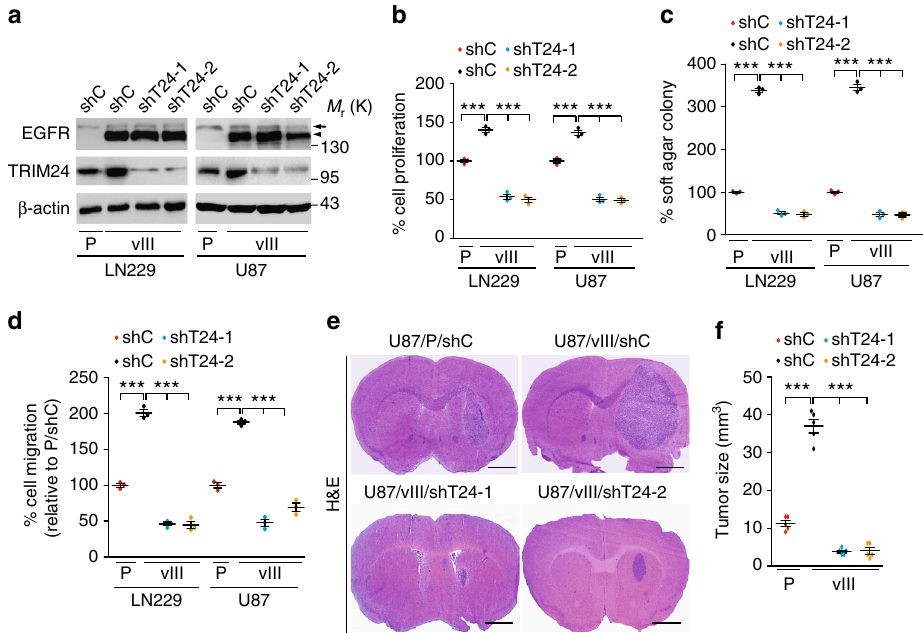
Fig. 3 Knockdown of TRIM24 inhibits EGFR-driven cell proliferation, cell survival, colony formation in soft agar, cell migration, and tumor growth. a WB assays of TRIM24 knockdown with two different shRNAs (shT24-1 and shT24-2) or a control shRNA in LN229 and U87 GBM cells with, or without EGFRvIII overexpression. Arrows, EGFR. Arrow heads, EGFRvIII. b – d Effects of TRIM24 knockdown by shT24 or shC on cell proliferation ( b ), colony formation in soft agar ( c ) and cell migration ( d ) in vitro. e Knockdown of TRIM24 inhibits brain xenograft growth of EGFRvIII-promoted U87 glioma cells. Representative images of H&E stained brain tumor xenograft with indicated U87 GBM cells. Scale bars: 1 mm. f Quanti fi cation of tumor size. Data were from H&E stained brain sections of fi ve mice per group of two independent experiments. Error bars, s.d. Data represent two or three independent experiments with similar results. *** P < 0.001, paired two-way Student ’ s t -test, compared with parental or EGFRvIII cells or tumors treated with EGFR promotes the association of H3K23ac and TRIM24 .